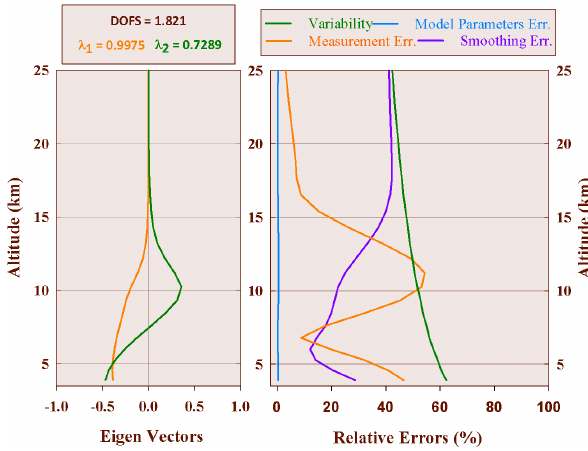
Figure 2. Typical results for information content and error budget. Left frame: first eigenvectors and corresponding eigenvalues. Right frame: error budget, with identification of the main error compo- nents, together with the assumed variability (see colour codes and Table 1 for additional